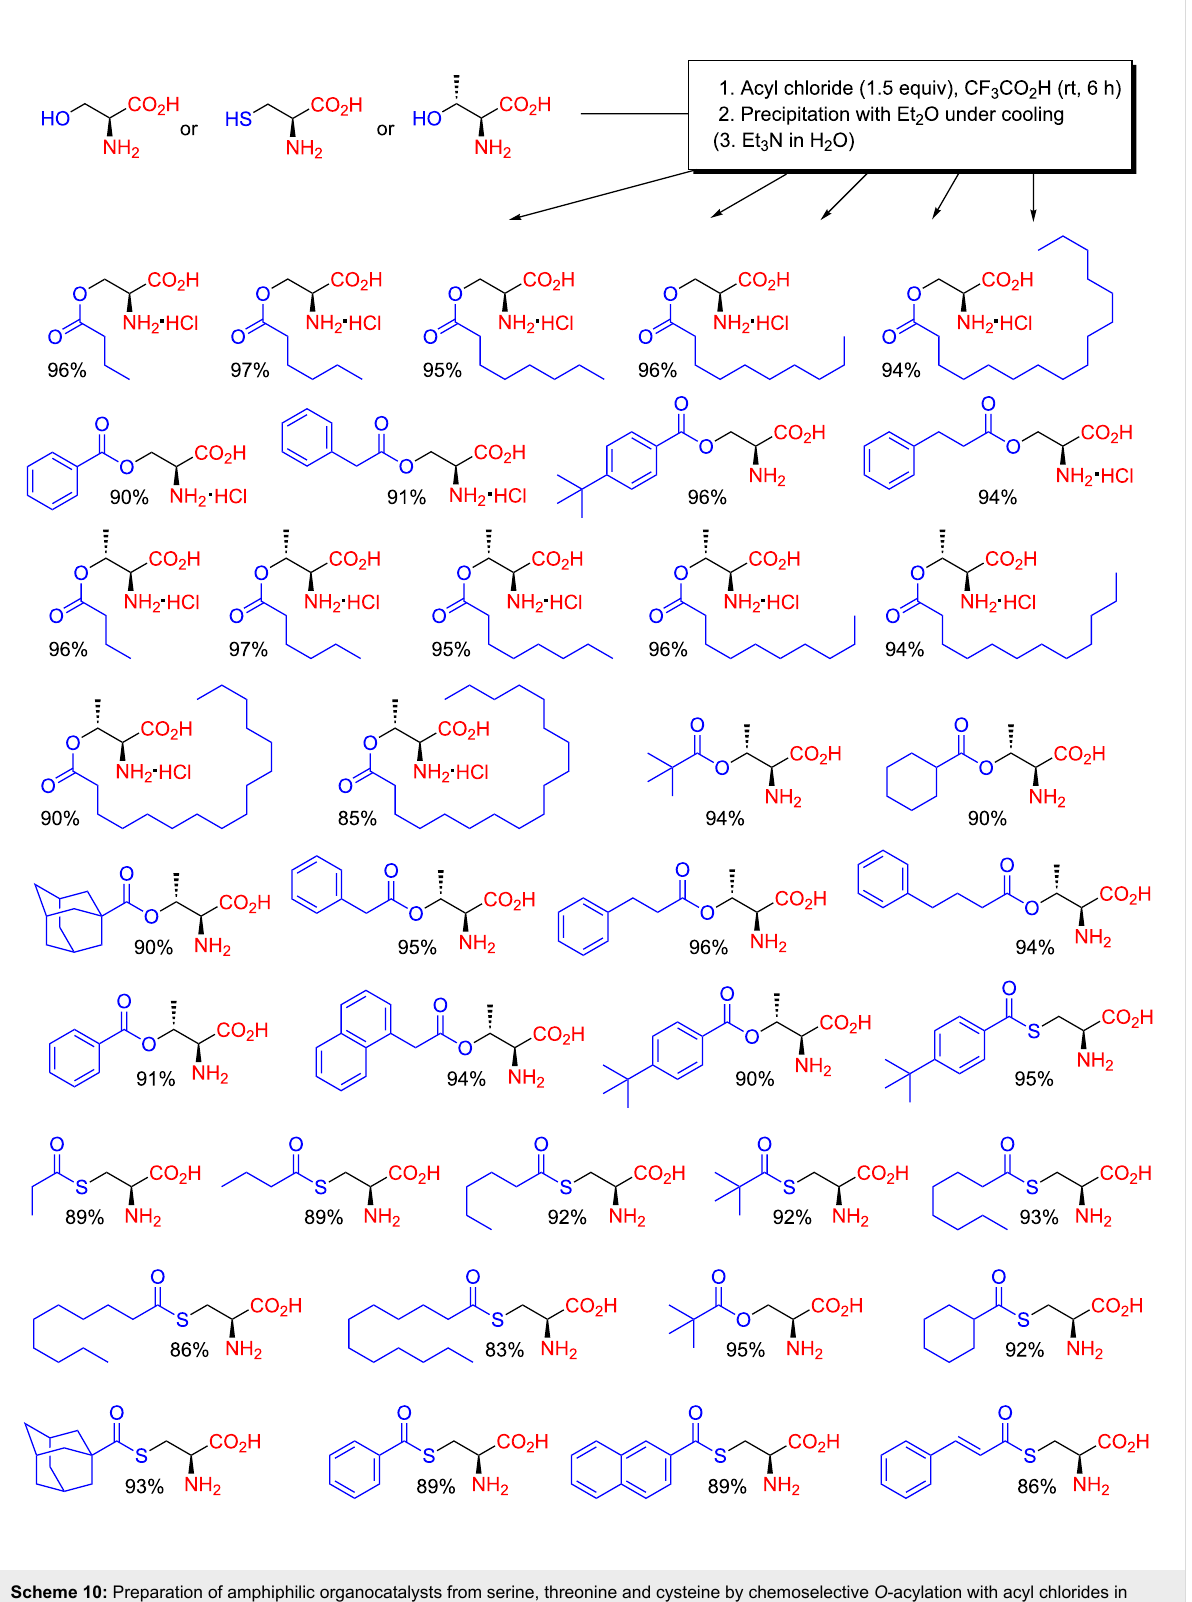
Scheme 10: Preparation of amphiphilic organocatalysts from serine, threonine and cysteine by chemoselective O -acylation with acyl chlorides in